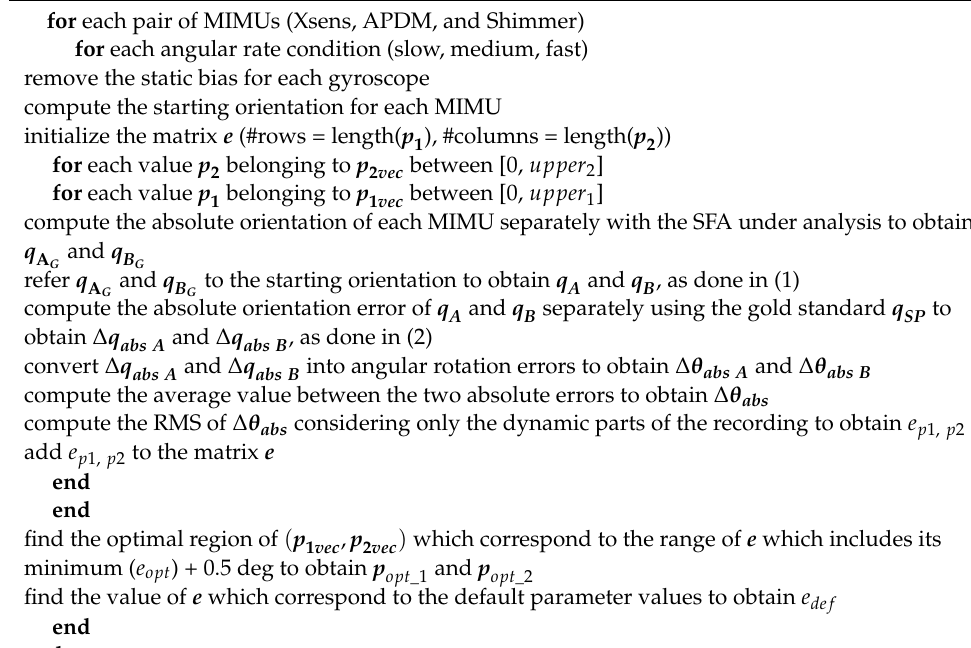
Algorithm 1. Pseudocode to detail the orientation estimation process for each